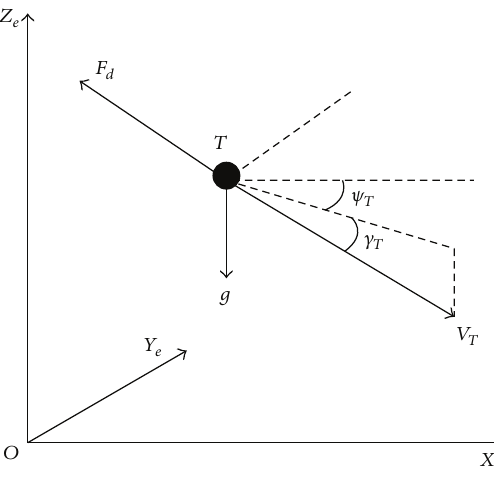
Figure 1: Forces acting on the ballistic target model.